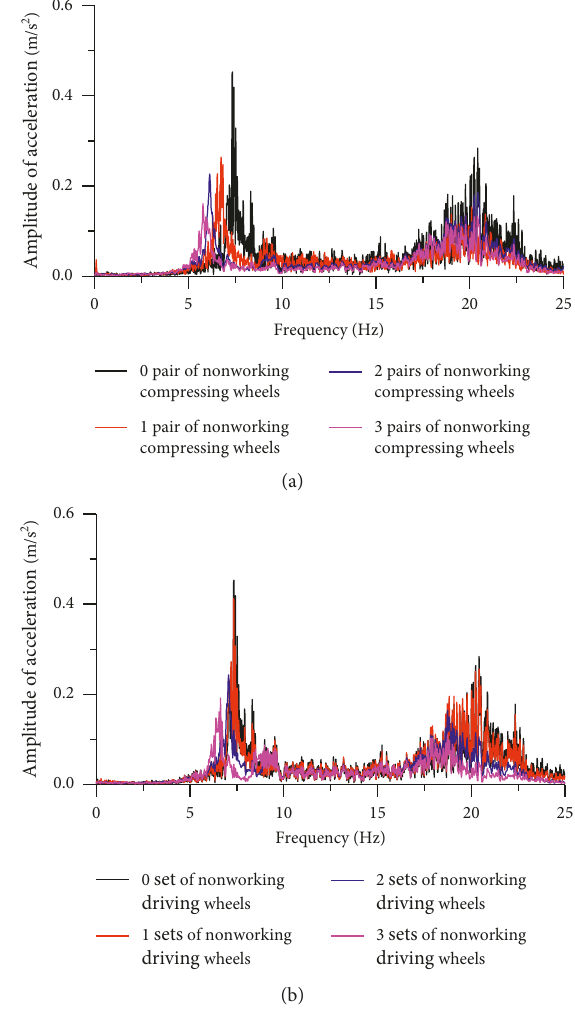
Figure 14: One-sided power spectrum density (PSD) of the vi- bration acceleration of the inspection vehicle vs. (a) the number of nonworking compression wheels and (b) the number of non- working driving